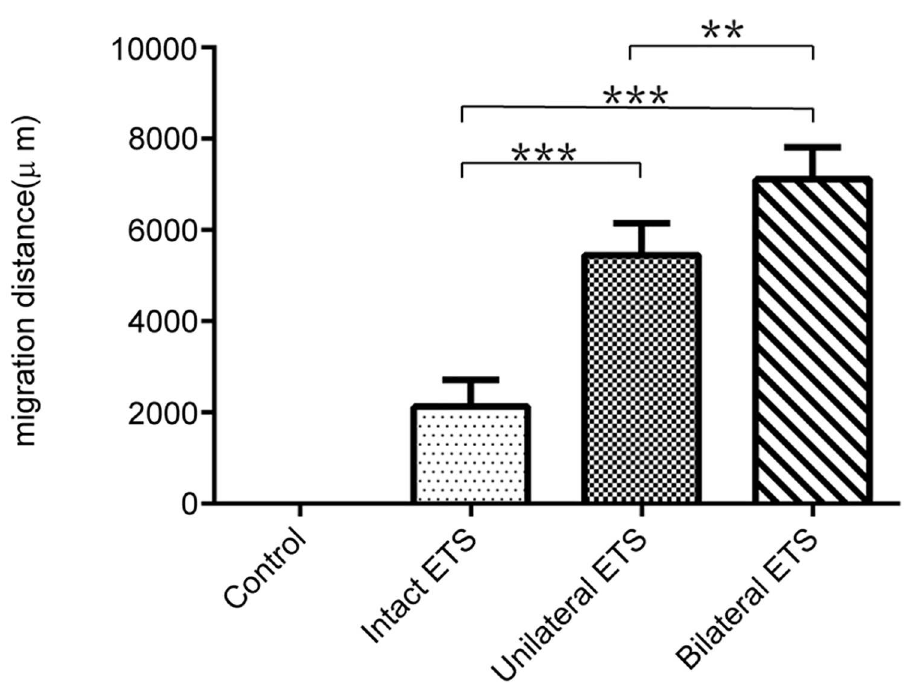
Fig 3. The distance of Schwann cell (SC) migration into the graft. The mean SC migration distancefrom edge of graft was assessed by confocalimagingof the wholemount graft (n = 4 per group). The bilateralend- to-side (ETS) group showedthe longest distancecomparedwith the other groups, followedby the unilateral ETS, intact ETS, and control groups. In addition, the control group did not show GFP-positive cells migrating into the graft. Differencesbetweenthe control and the other groupswere significant(p < 0.001). ** p < 0.01, *** p <